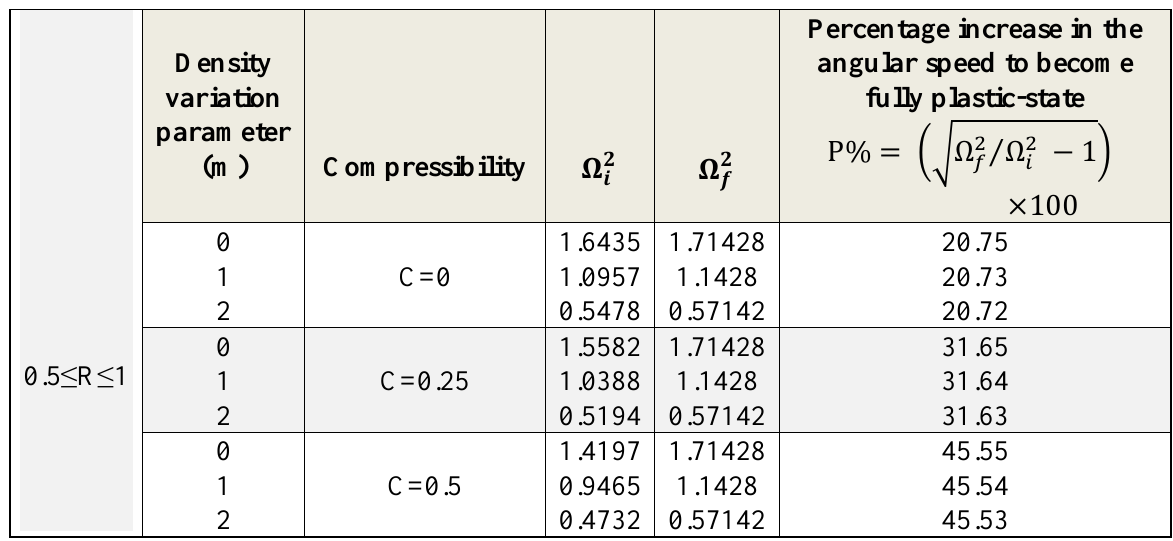
Table1. Angular speed required for initial yielding and fully plastic